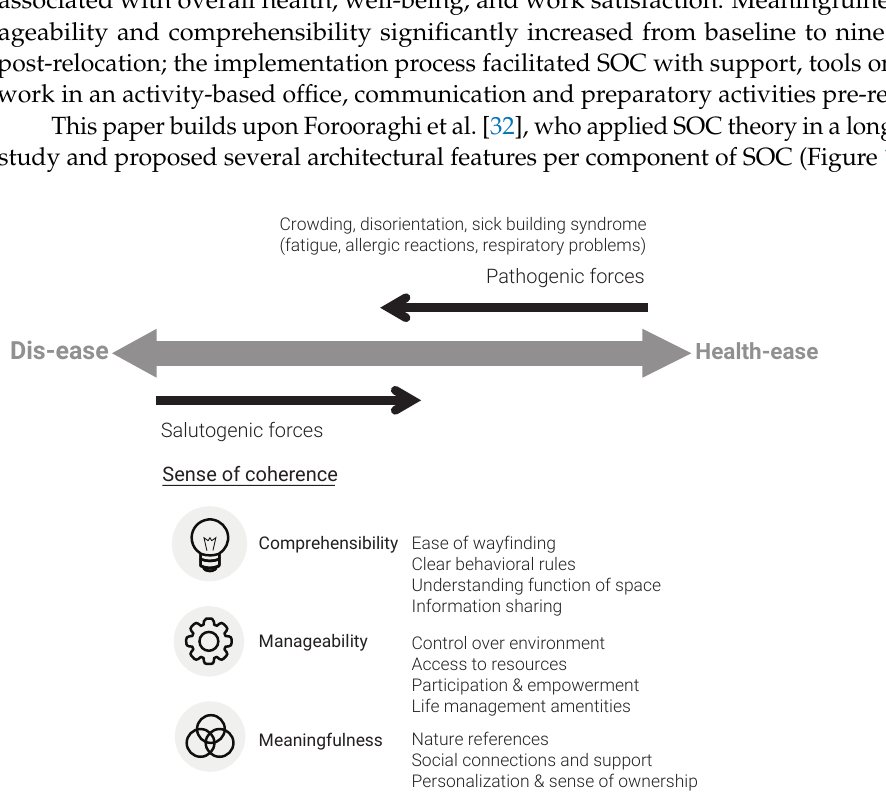
Figure 1. Sense of coherence in an office environment, adapted from Forooraghi et al. [32]. Comprehensibility in the office context relates to the features that make the environment structured, predictable, and